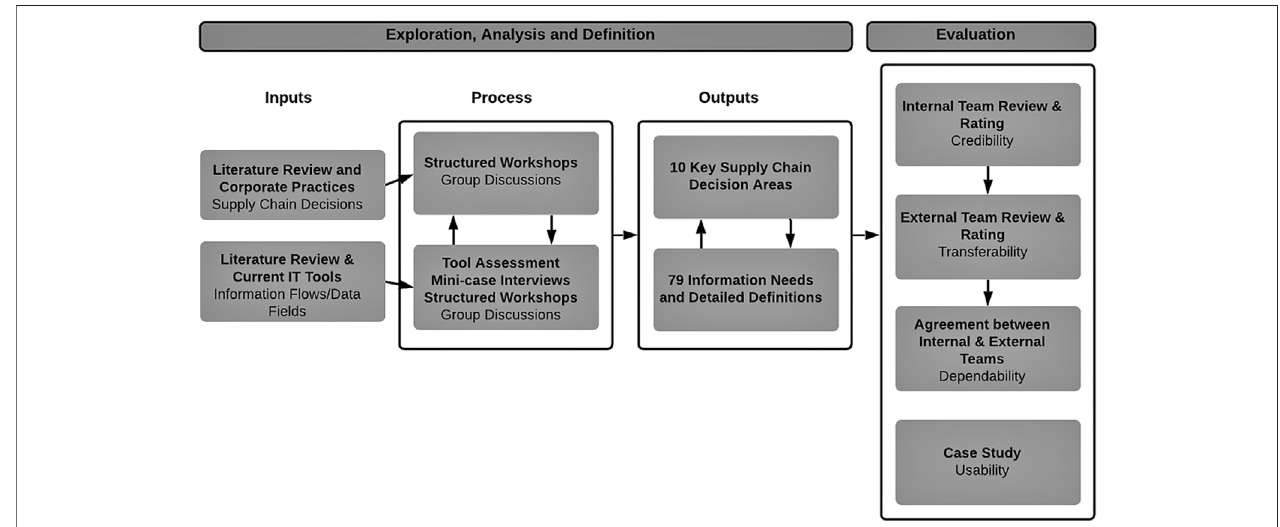
FIGURE 1 | Research